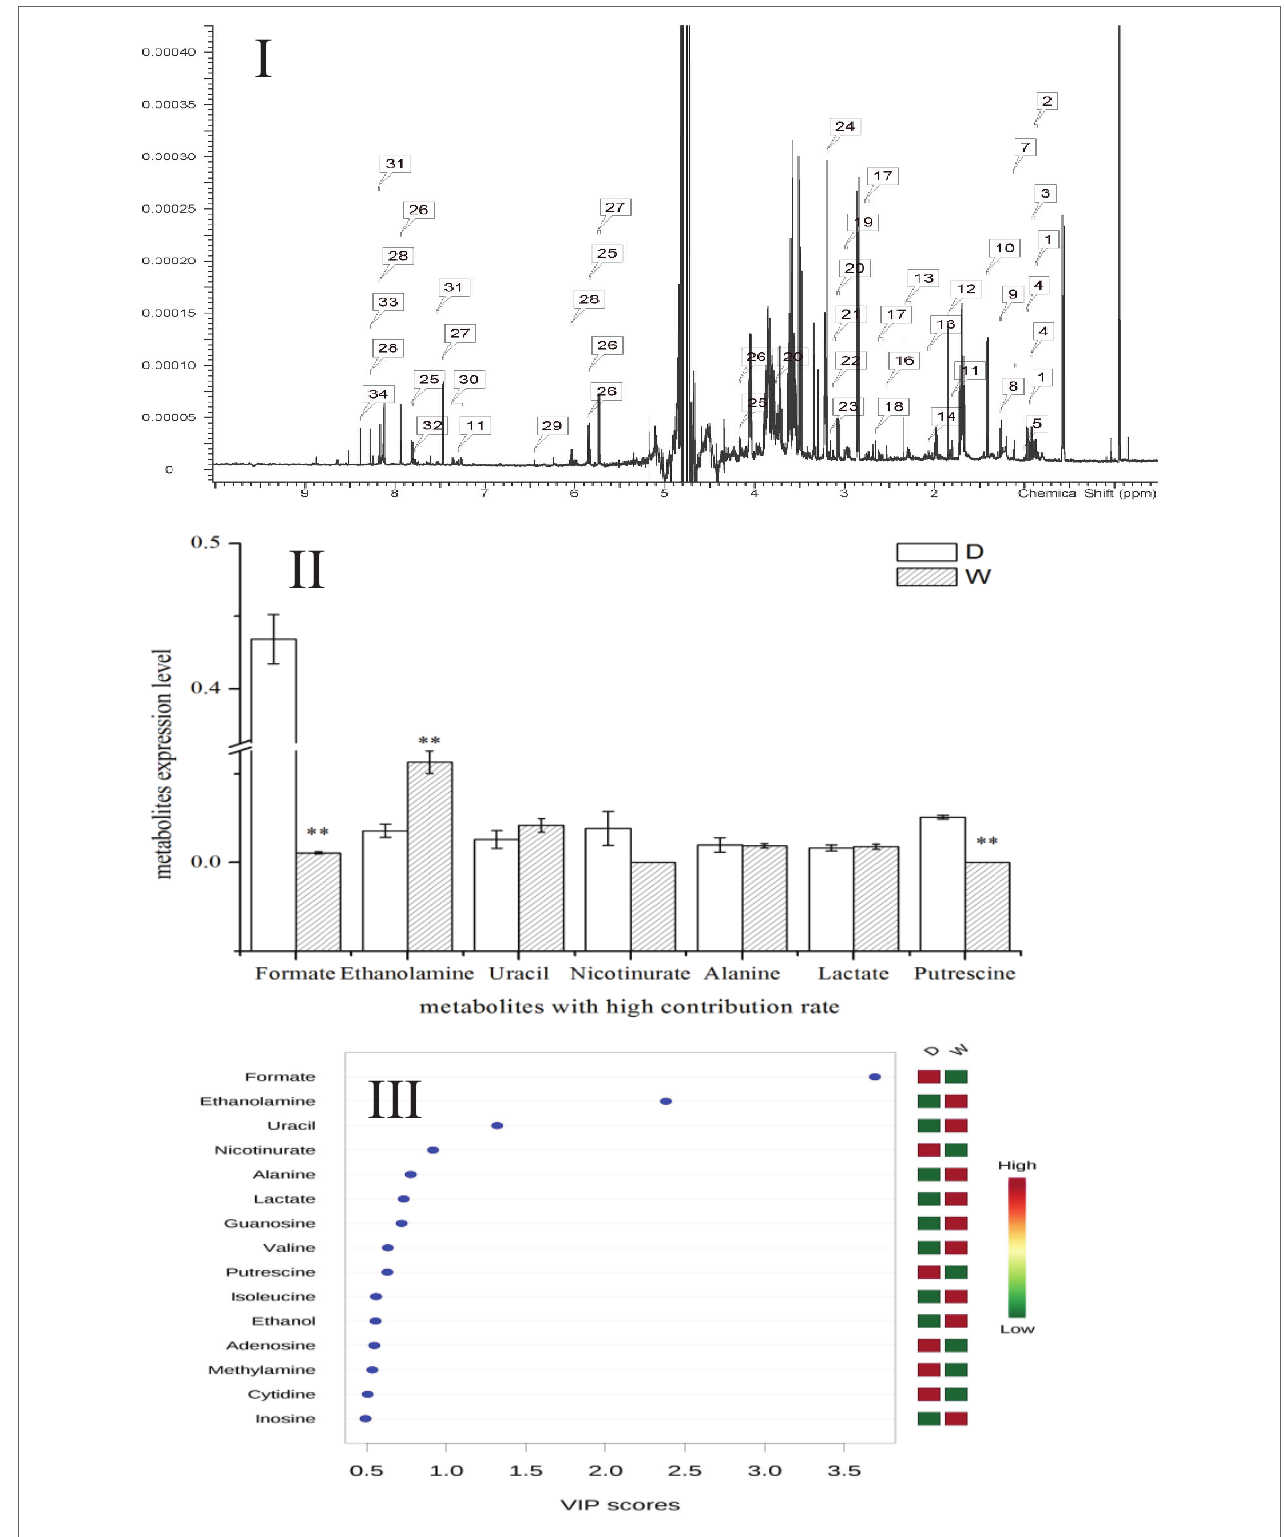
FigUre 3 | (i) NMR ownership figure of metabolites from S. putrefaciens. (ii) Expression levels of bacteria in freshwater and water environment of high contribution rate metabolites. W, water group (control); D, sewage group (experimental) (** P < 0.01). (iii) The PLS analysis graphics of intracellular metabolites from S. putrefaciens. VIP, variable importance in